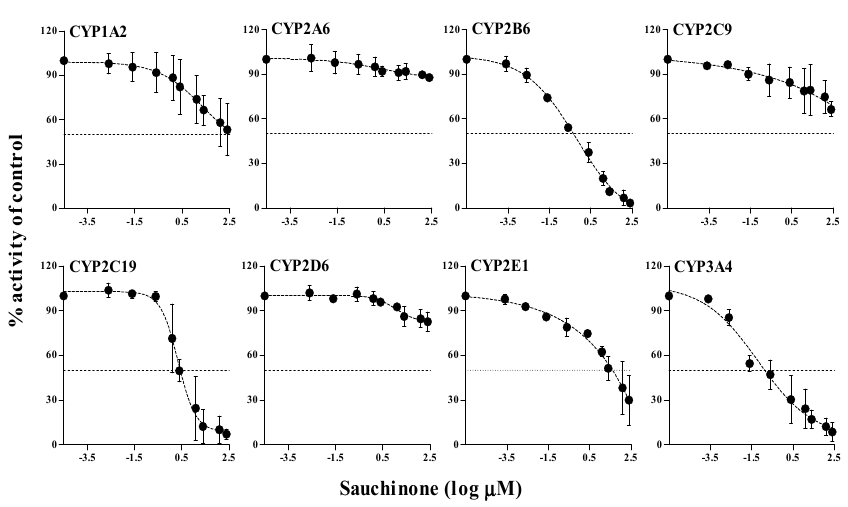
Figure 1. IC 50 curves of sauchinone for RI on CYP1A2, CYP2A6, CYP2B6, CYP2C9, CYP2C19, CYP2D6, CYP2E1, and CYP3A4 in HLMs. Y-axis is expressed as the remaining percentage of activity with sauchinone compared with the control (without sauchinone).